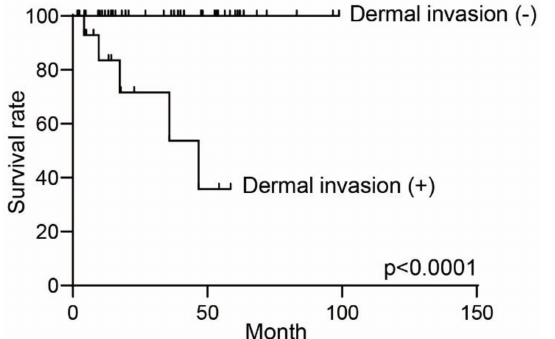
Figure 2. Difference of overall survival curve with or without dermal invasion in extramammary Paget’s disease. The overall survival curves were drawn using the Kaplan–Meier method and were compared with the log-rank